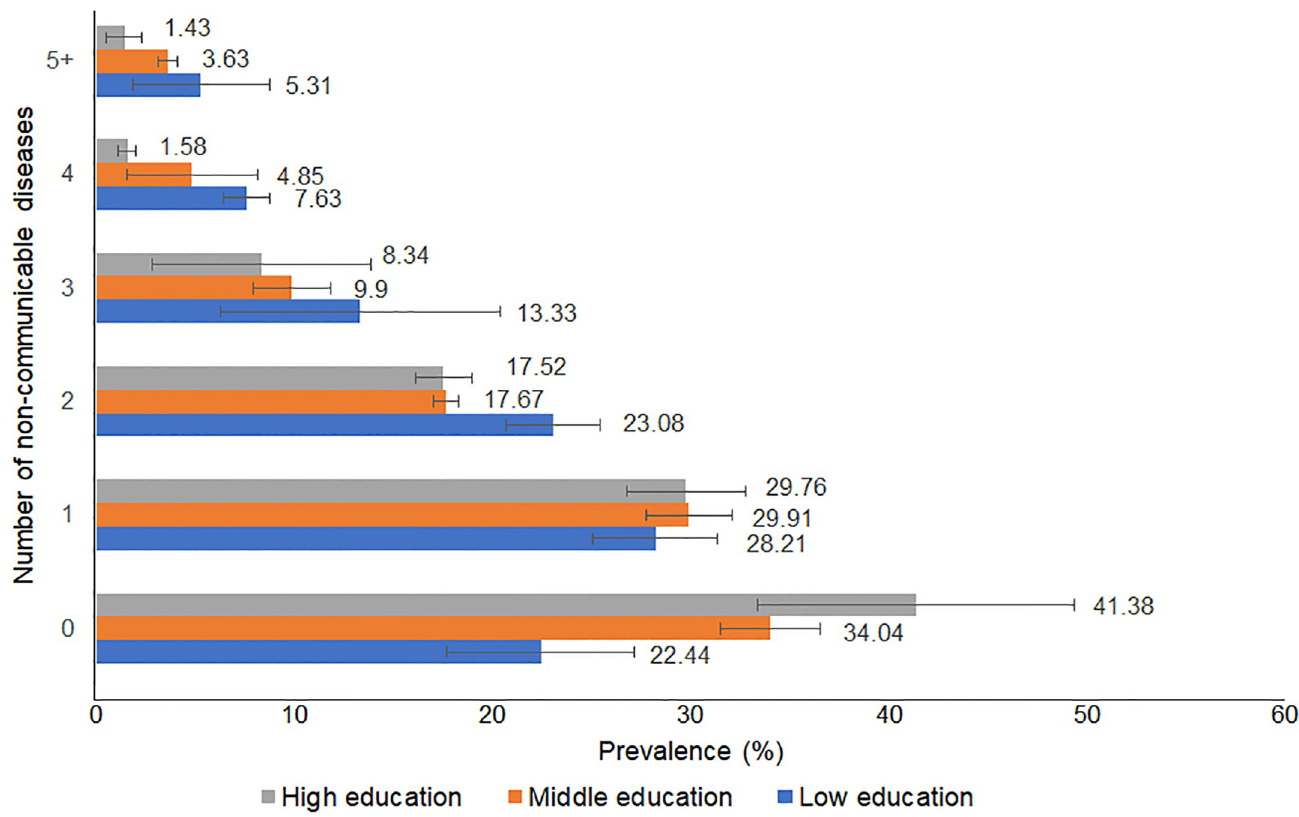
Fig 1. Prevalence of multimorbidity stratified by education level (Australia) + . + The 12 non-communicable diseases (NCDs) include arthritis, cancer, type 1 diabetes, type 2 diabetes, heart diseases, hypertension, asthma, bronchitis, depression, anxiety, other mental diseases, circulatory conditions.